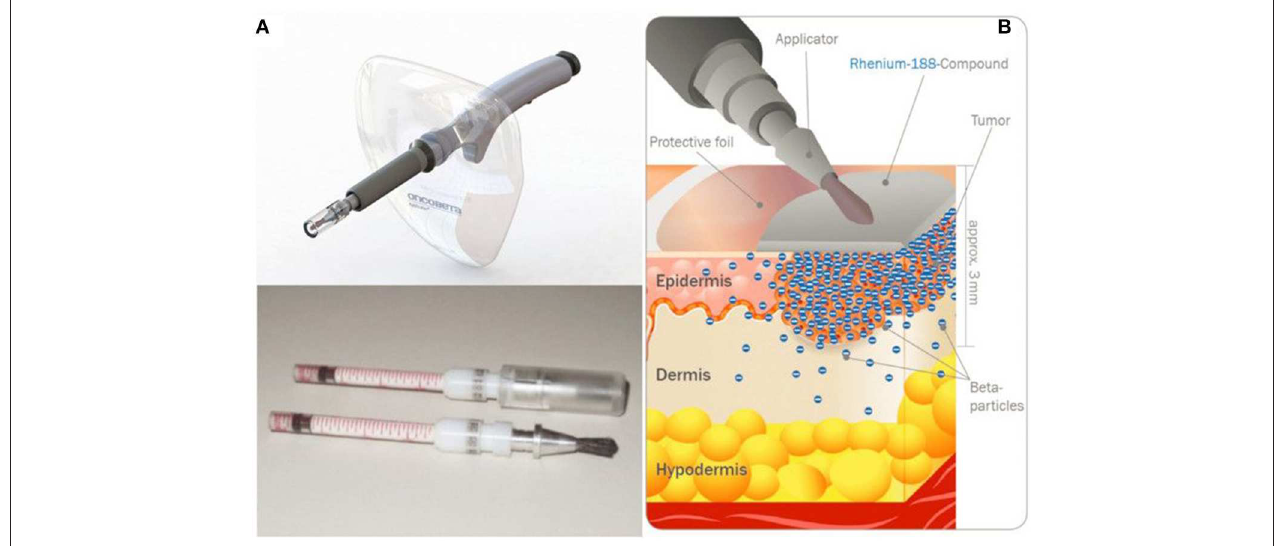
FIGURE 10 | Rhenium-SCT device developed by OncoBeta ® GmbH (Garching, Germany). Applicator and dispensing carpoules filled with 188 Re-cream (A) and illustration of the principle (B) (Courtesy of Dr. Shannon Brown III, OncoBeta ® ).